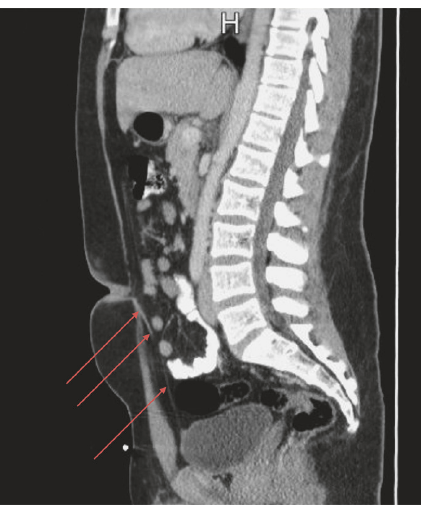
Figure 1: Computed tomography (CT) scan of the abdomen and pelvis sagittal plane showing a urachal remnant (red arrows) arising from the anterior/superior margin of the bladder and extending to the umbilical region. The remnant consists of a thin fibrous band of tissue measuring up to 4.6mm in thickness near the umbilicus although measures as narrow as 2.0 millimeter along its course.